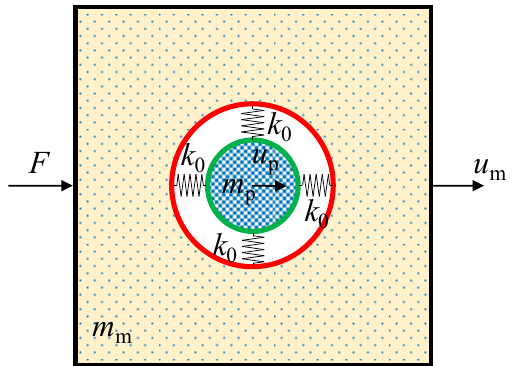
Figure 1. Vibrator model of a coated particle embedded in a matrix.